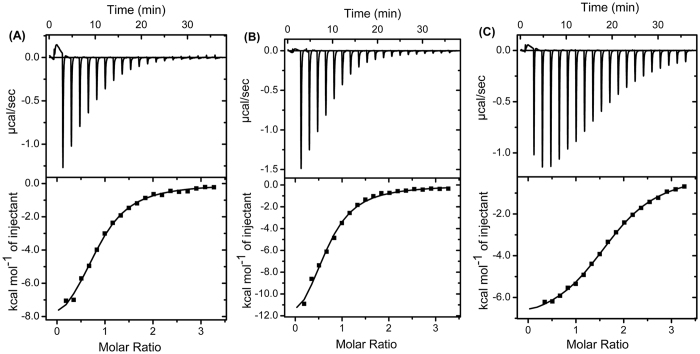
The binding of chensinin-1 analogues with LPS monitored by isothermal calorimetric titration in 10 mM sodium phosphate buffer (pH 6.0) at 37 °C, (A) MC1-1, (B) MC1-2, and (C) MC1-3.